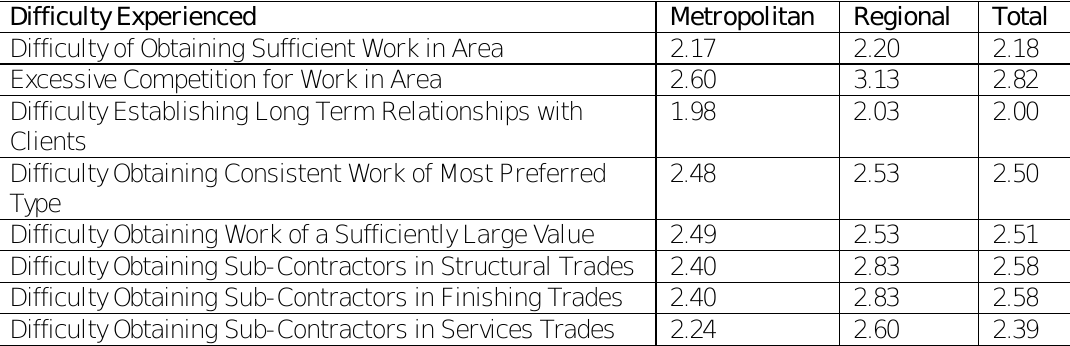
Table 6: Mean Likert values for market difficulties Difficulty Experienced